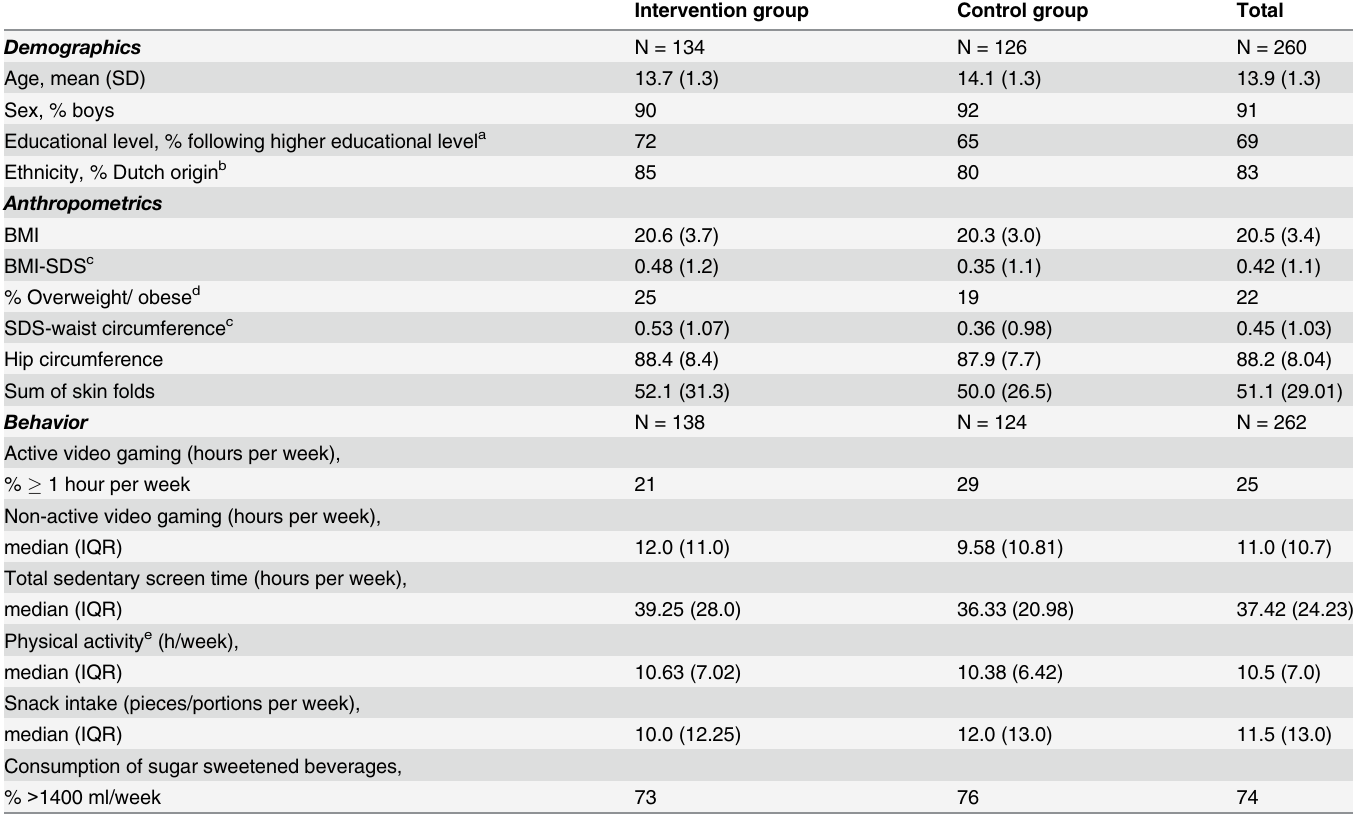
Table 1. Baseline characteristics of adolescent study participants (mean (SD) or